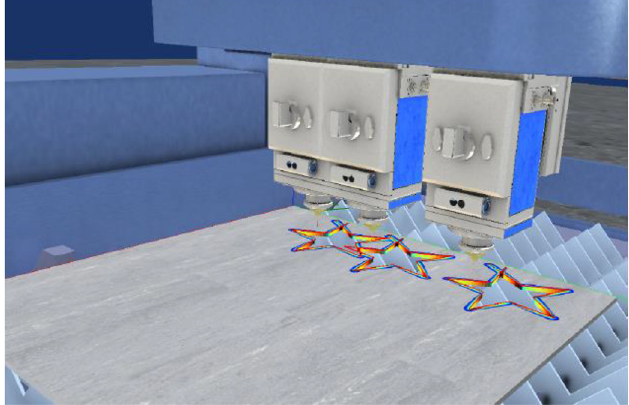
Fig. 4. Interactive simulation for multi-laser cutting process (3 laser heads)